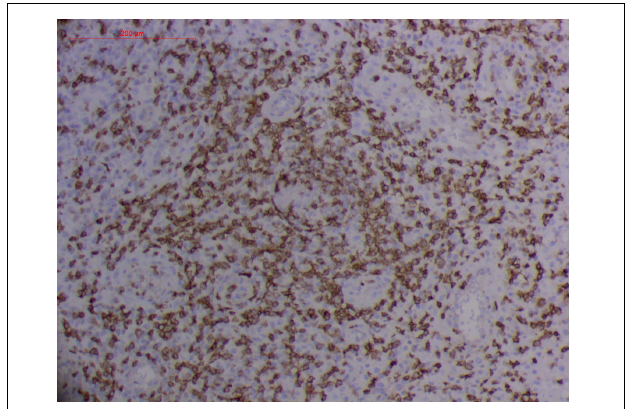
FIGURE 12 | Extranodal natural killer/T cell lymphoma, nasal type-orbital-cerebral mycosis.” Rhizopus arrhizus -induced positive expression of CD8 from granulomatous tissues (envision method, original magnification × 200).